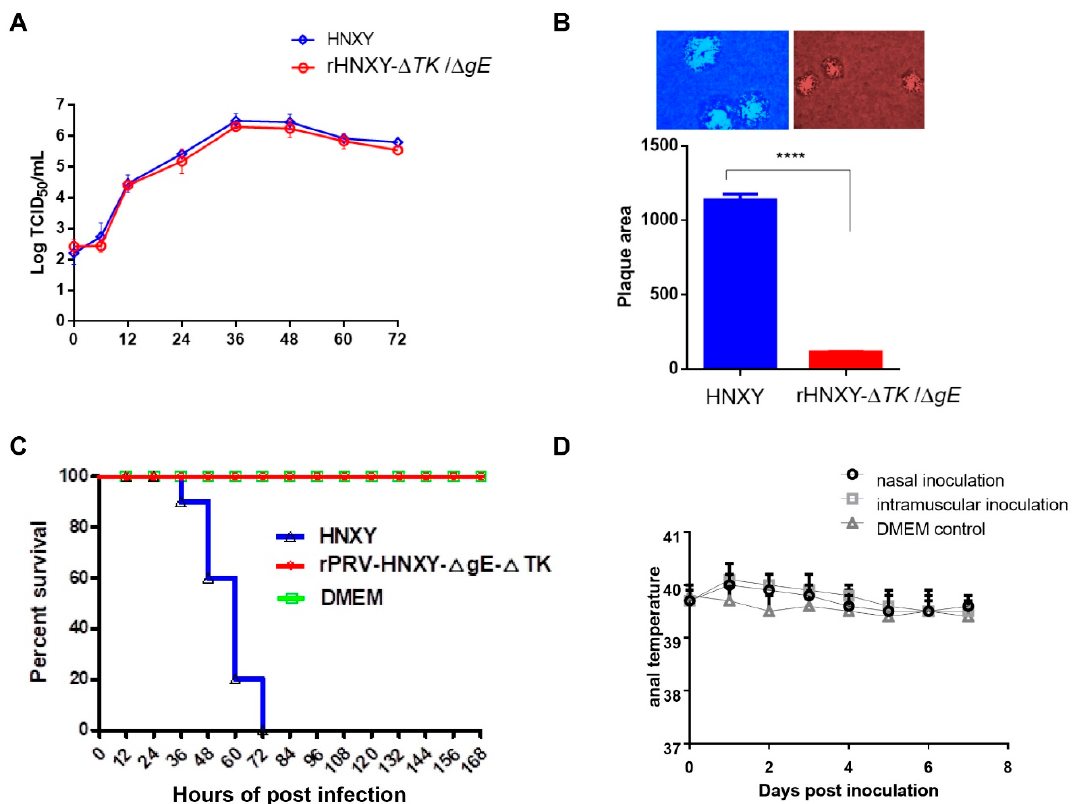
Figure 5. Growth characteristics and safety of HNXY- ∆ TK / ∆ gE . ( A ) One step growth analysis of HNXY- ∆ TK / ∆ gE and HNXY. ( B ) rHNXY- ∆ TK / ∆ gE formed significantly smaller plaques than HNXY. **** rHNXY- ∆ TK / ∆ gE formed significantly smaller plaques than HNXY. ( C ) The survival of the mice infected with rHNXY- (cid:52) TK / (cid:52) gE and HNXY in 10 5 TCID 50 . ( D ) The anal temperatures of 0-day-old pigs inoculated with rHNXY- (cid:52) TK / (cid:52) gE by nasal or intramuscular during the